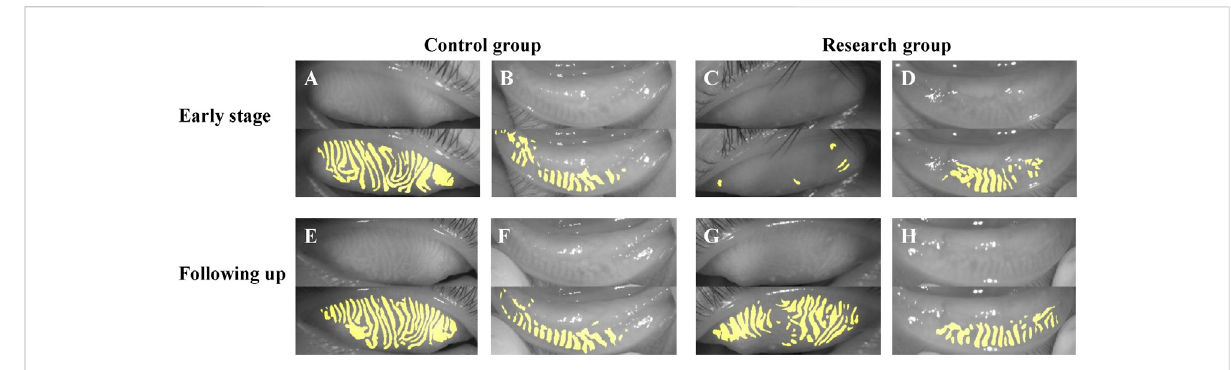
FIGURE 6 The follow-up results of a child. (A – D) showed the photograph of MG in the early stage of HZO, and (E – H) showed the photographs of MG following 2 years after HZ infection. (A,B,E,F) were the control eyes without HZ infection, and (C,D,G,H) were the research eyes with HZ